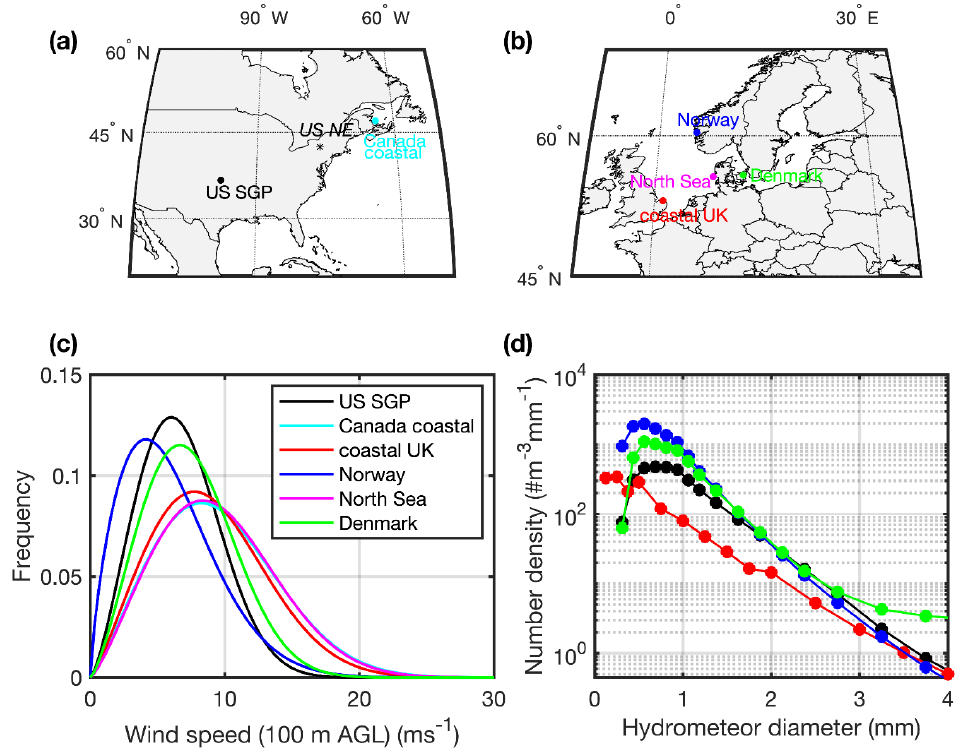
Figure 4. ( a , b ) Maps of locations from which data are presented (see details in Table 1). ( c ) Probability distributions of wind speeds at 100 m AGL at those locations based on once-hourly output from the ERA5 reanalysis for 1979 – 2018. ( d ) Observed mean droplet size distributions for four of the locations based on measurements with the optical disdrometers for liquid precipitation and RR of 6 – 11 mmhr −1 . Colors used in frames ( c , d ) indicate the different locations and are as shown in frames ( a , b ). Non-parametric Spearman (rank) correlation coefficients (r s ) are reported as a meas- ure of the degree of agreement between two data sets. This measure of correlation is ap- propriate for use with data, such as RR, that are not Gaussian distributed [123]. Linear fitting is undertaken and is expressed in terms of the slope ( m ) and the intercept ( c ) of the general linear model, where x is the independent variable and y is the dependent variable: 𝑦 = 𝑚𝑥 + 𝑐 (18) To illustrate RR and DSD from different instrument metrologies we examine data from three disdrometers deployed at the US SGP site (Figure 4a). The degree of closure between RR is assessed using three different thresholds (RR > 0.1, 1 and 10 mmhr − 1 ) using contingency-table based metrics; the Hit Rate (HR) and the False Alarm Rate (FAR) [123]. The HR, which is also known as the proportion correct, is the ratio of the number of times data from the two instruments agree on precipitation occurrence for each of the thresh- olds, to the total number of times that the reference instrument (in this case the OTT Par- sivel 2 ) exhibited a RR in excess of that threshold. The FAR, is a measure of the number of times both instruments indicated RR below the specified threshold, to the number of times